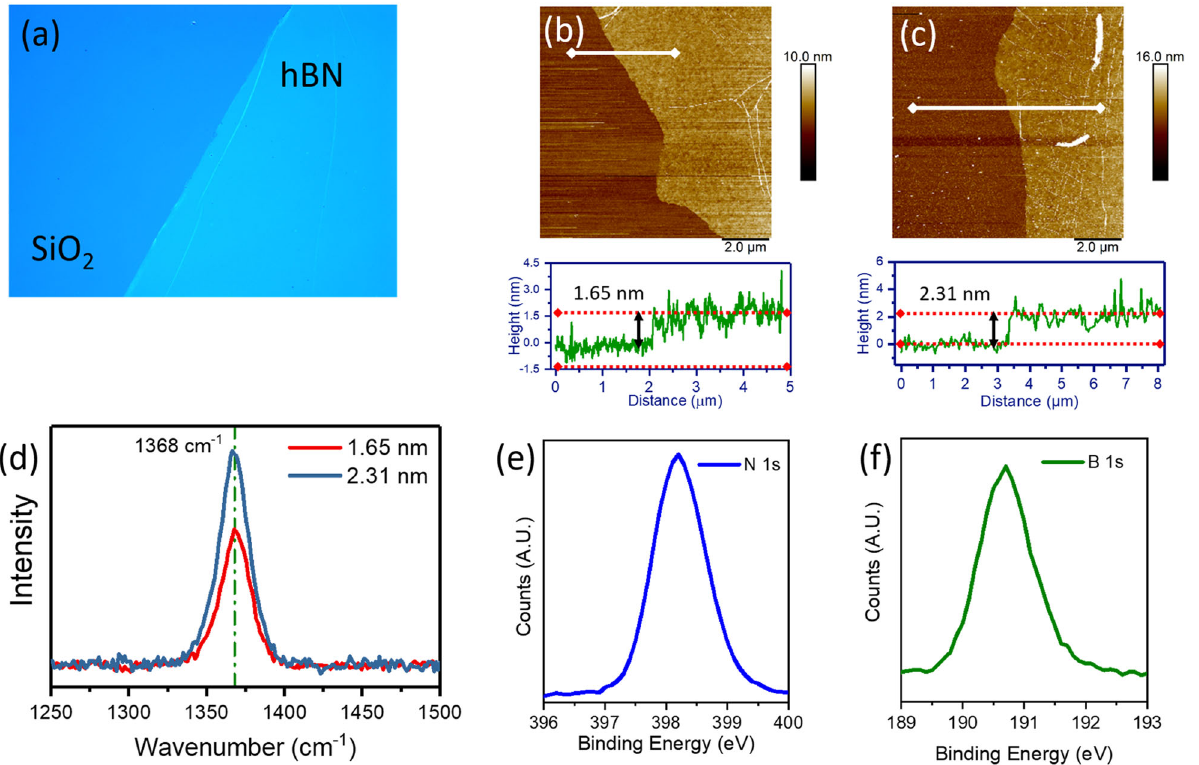
Fig. 1 Characterization of 2D hBN thin fi lm. a Optical micrograph of hBN monolayer transferred onto a SiO 2 /Si substrate for AFM and Raman characterization. AFM results of b 5 ML and c 7 ML hBN. The scanned height variation of the fi lm is shown below the AFM image. d Thickness- dependent Raman intensity of the hBN layer. XPS spectra of e B-1 s and f N-1 s of the hBN layer transferred onto